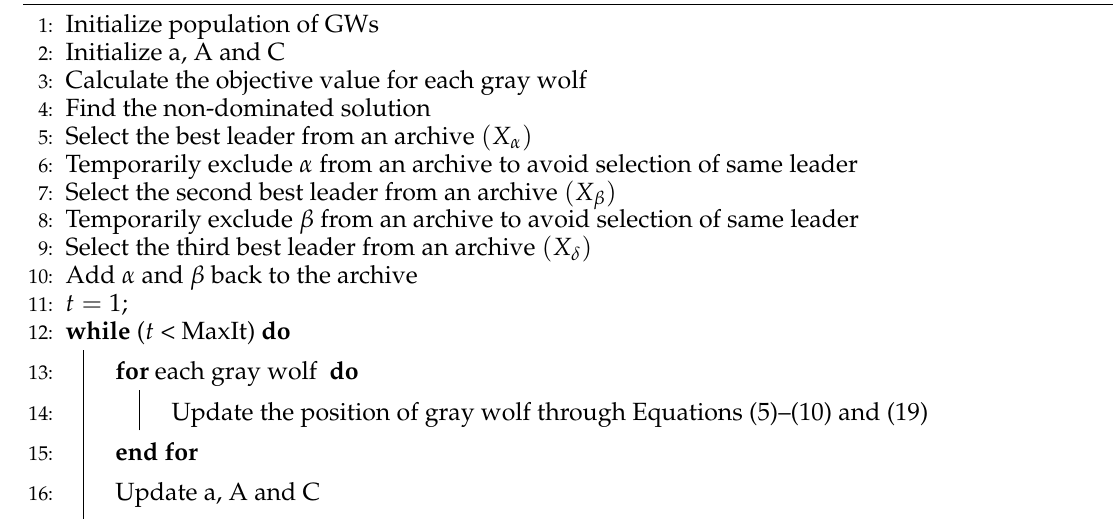
Algorithm 2 Pseudocode of the LMOGWO